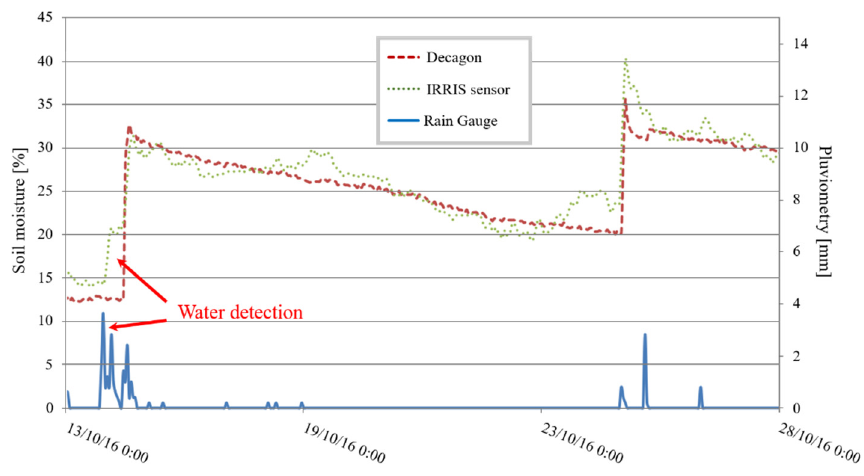
Figure 33. Sensors’ tests in an orchard.